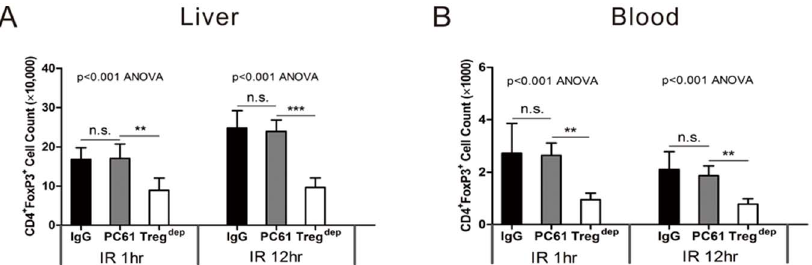
Figure 7. The number of Tregs did not change significantly when anti-CD25 mAb were administered shortly before IR insult. After 1 hour or 12 hours of reperfusion, total hepatic nonparenchymal cells and spleen cells were isolated and gated on 7-AAD 2 CD45 + before the analysis. Tregs were identified as CD4 + /FoxP3 + . Data are mean values 6 SE; n=6 per group. (n.s. P . 0.05 **P , 0.01, ***P , 0.001).